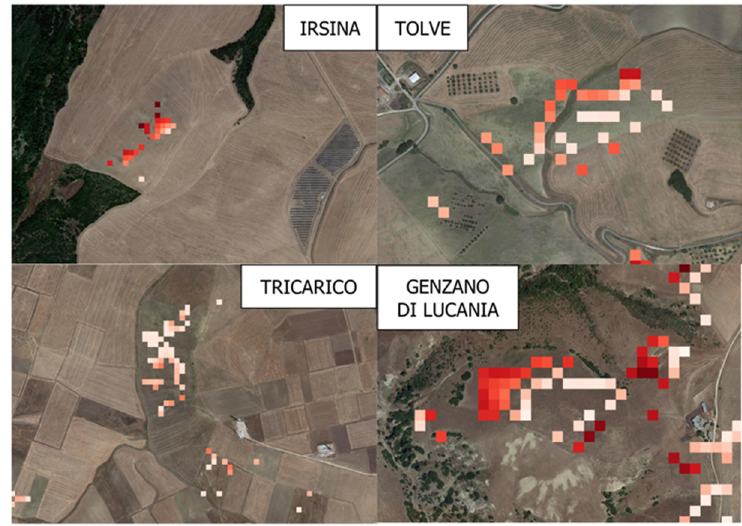
Figure 8. Detailed examples of areas subject to land degradation on arable land in four different areas. Table 4. Extension of the areas subject to degradation cultivated with arable land in degradation concerning the factor C .